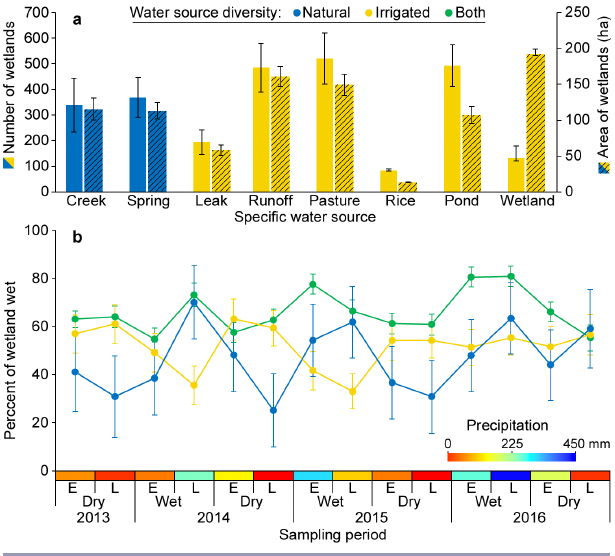
Fig. 2 . Mapped water features in the Sierra Nevada foothills, clustered in irrigation district service areas (inset: study area location in California).